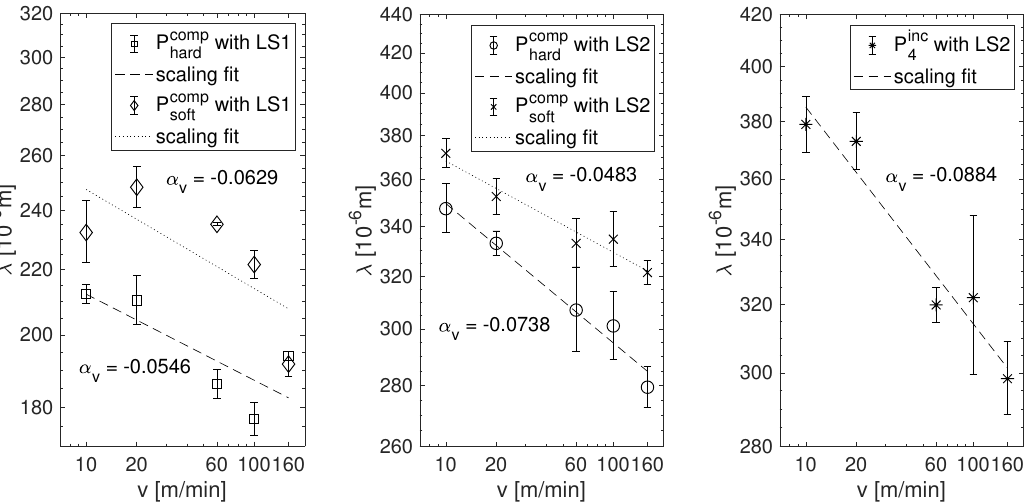
Figure 5. The finger wavelength λ as a function of printing velocity v for different printing forms and fluids in double logarithmic plots: ( Left ) compressible printing plates with printing fluid at standard formulation; ( Middle ) compressible printing plates with diluted fluid; and ( Right ) incompressible elastomer printing plate with diluted